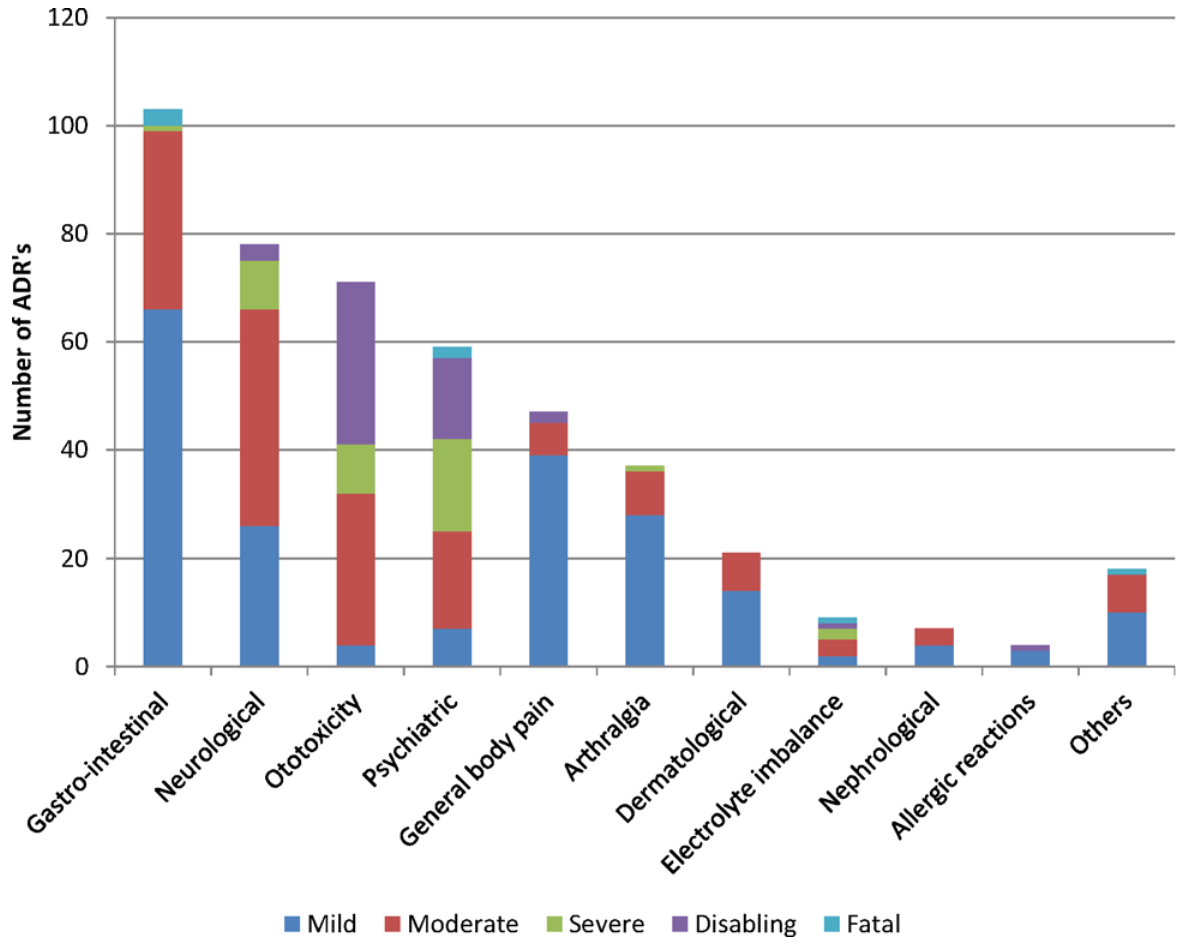
Fig 2. Number and severity of adverse events among MDR-TB patients in Nigeria, 2012 – 2013 (N = 482).